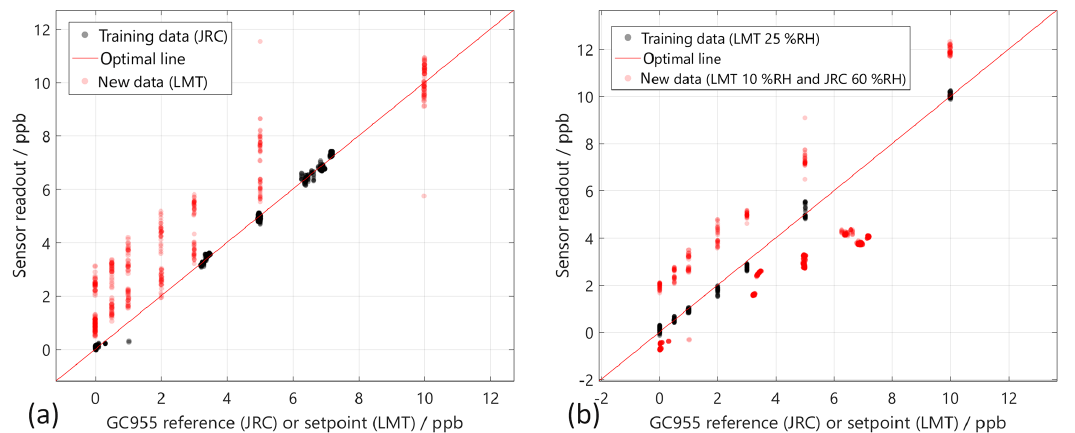
Figure 4. Transfer of the PLSR model from training data of one gas mixing system to test data from another gas mixing system. (a) Training using the JRC measurement (60%RH black solid circles) and test data from the LMT measurement (10 and 25%RH open red circles). (b) Training using LMT measurements (25%RH black circle) and test using the JRC data (60%RH) and the LMT data (10%RH). Both test data are shown in open red